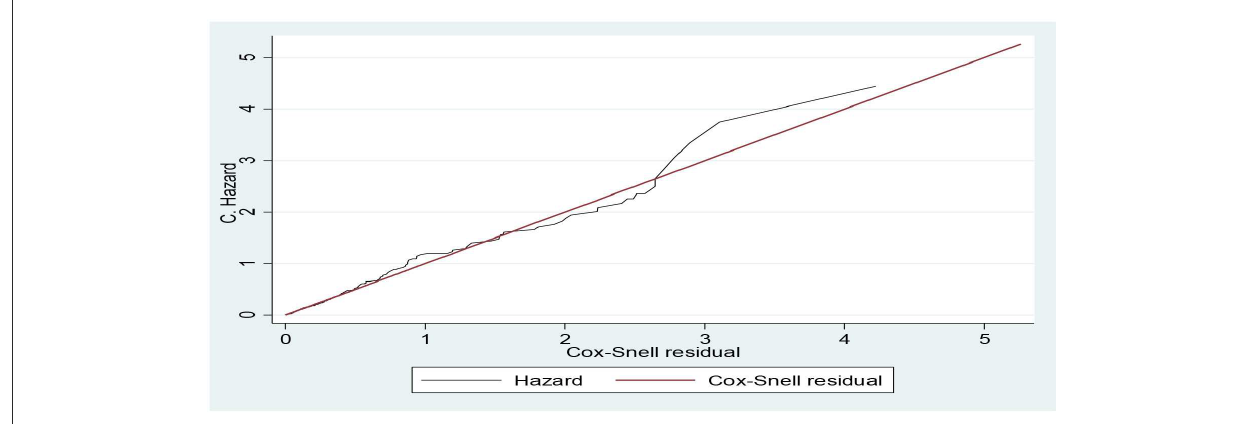
FIGURE2 Cumulative hazard vs. Cox–Snell residual plots for Cox regression model diagnosis of the data of adult patients with diabetes in Bahir Dar public hospitals, North West Ethiopia, 2021 ( n =